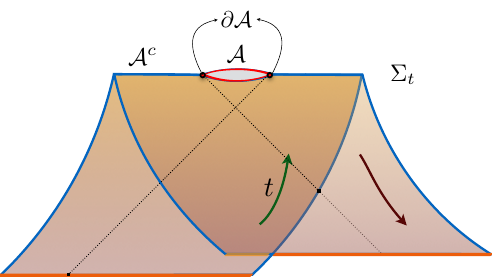
Figure 3. The timefolded Schwinger-Keldysh geometry B computing the matrix elements of ρ for a quantum theory on a fixed background. The forward and backward evolutions are glued together on the partial Cauchy slice Σ , except for a cut around A . We have also indicated the t past light-cones from the entangling surfaces which serve to demarcate the Milne and the Rindler wedges defined in the main text. In the gravitational context, the boundary geometries will be of this